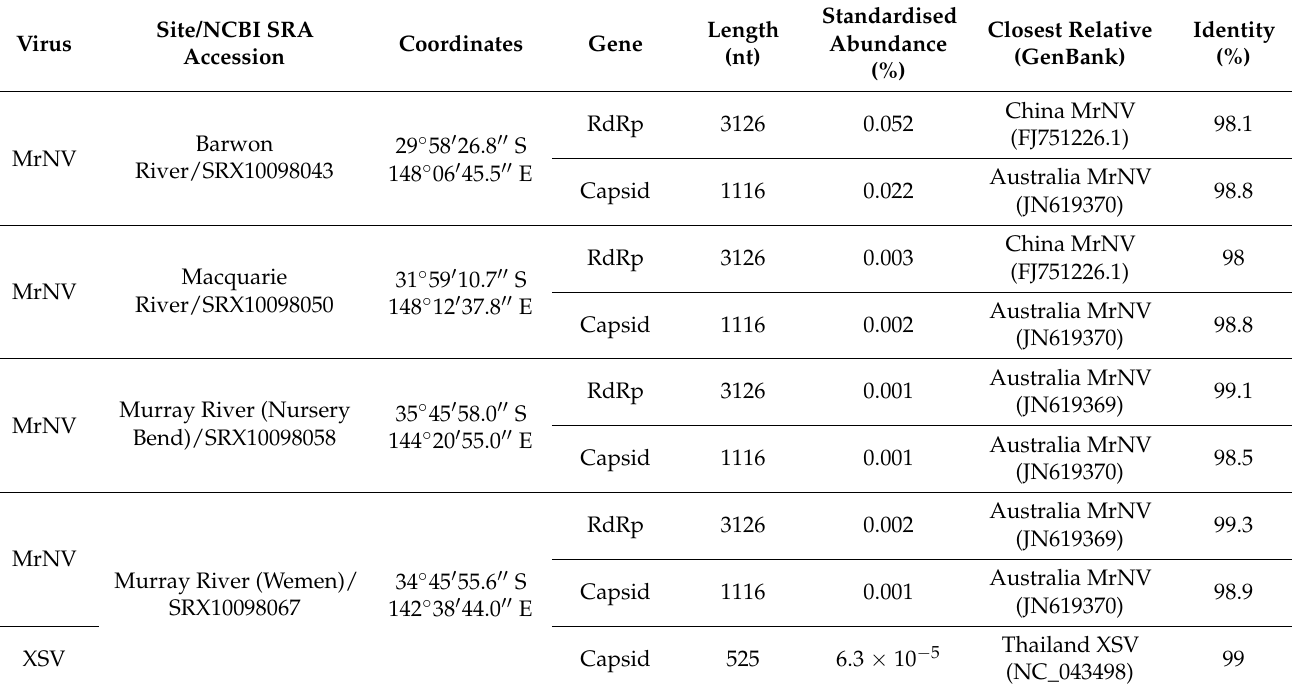
Table 1. Description of novel MrNV and XSV genomes identified in the